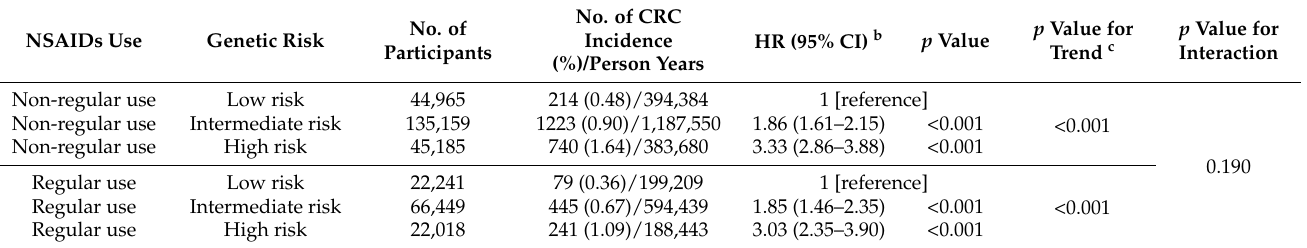
Table 3. The CRC incidence risk in accordance with genetic risk categories according to NSAID use a .